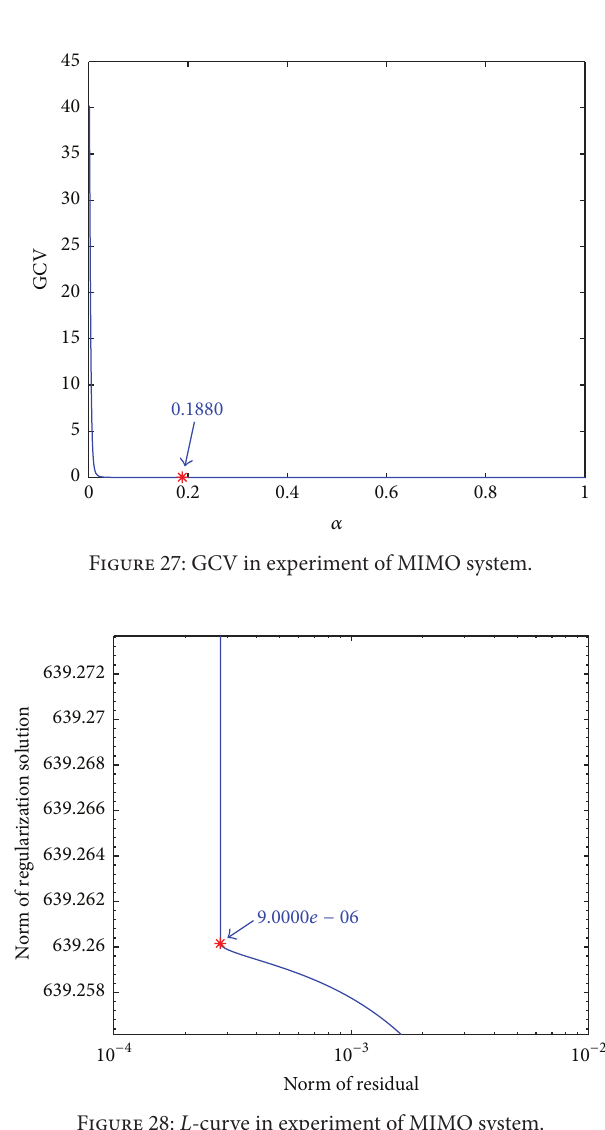
Figure 28: L -curve in experiment of MIMO system.